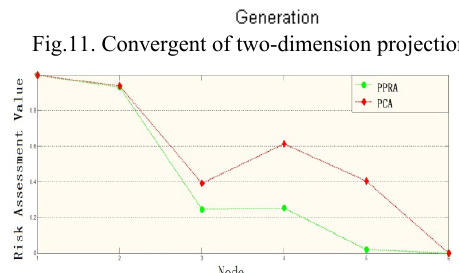
Fig.12. Compare of PP and